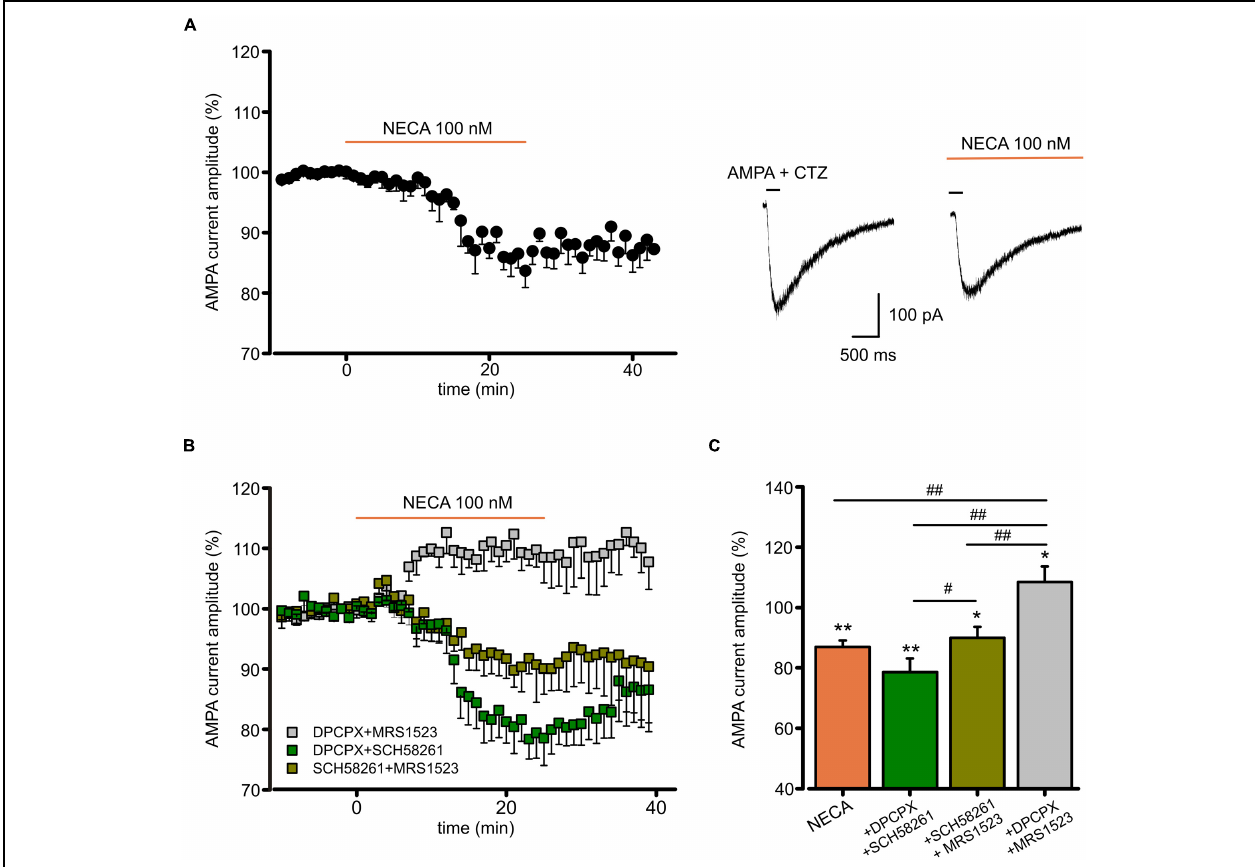
FIGURE 5 | N -ethyl 1-5 (cid:2) carboxamido adenosine (NECA) modulates postsynaptic AMPA receptors through multiple ARs. (A) Time course and representative traces of AMPA (100 μ M plus CTZ 25 μ M) current amplitude reduction induced by NECA ( t = 25 min) (100 nM) in hippocampal CA1 neurons ( n = 6; p < 0.01). (B,C) Time course and bar chart (at t = 25 min) of the effect of NECA in the presence of combination of ARs antagonists: DPCPX (100 nM) plus MRS1523 (100 nM) (gray; n = 6; p < 0.01); SCH58261 (30 nM) plus MRS1523 (dark green; n = 6; p < 0.05); DPCPX plus SCH58261 (green; n = 5; p < 0.01).